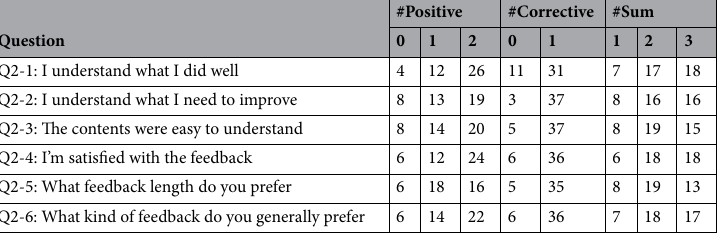
Table 7. Questionnaire summaries about user feedback